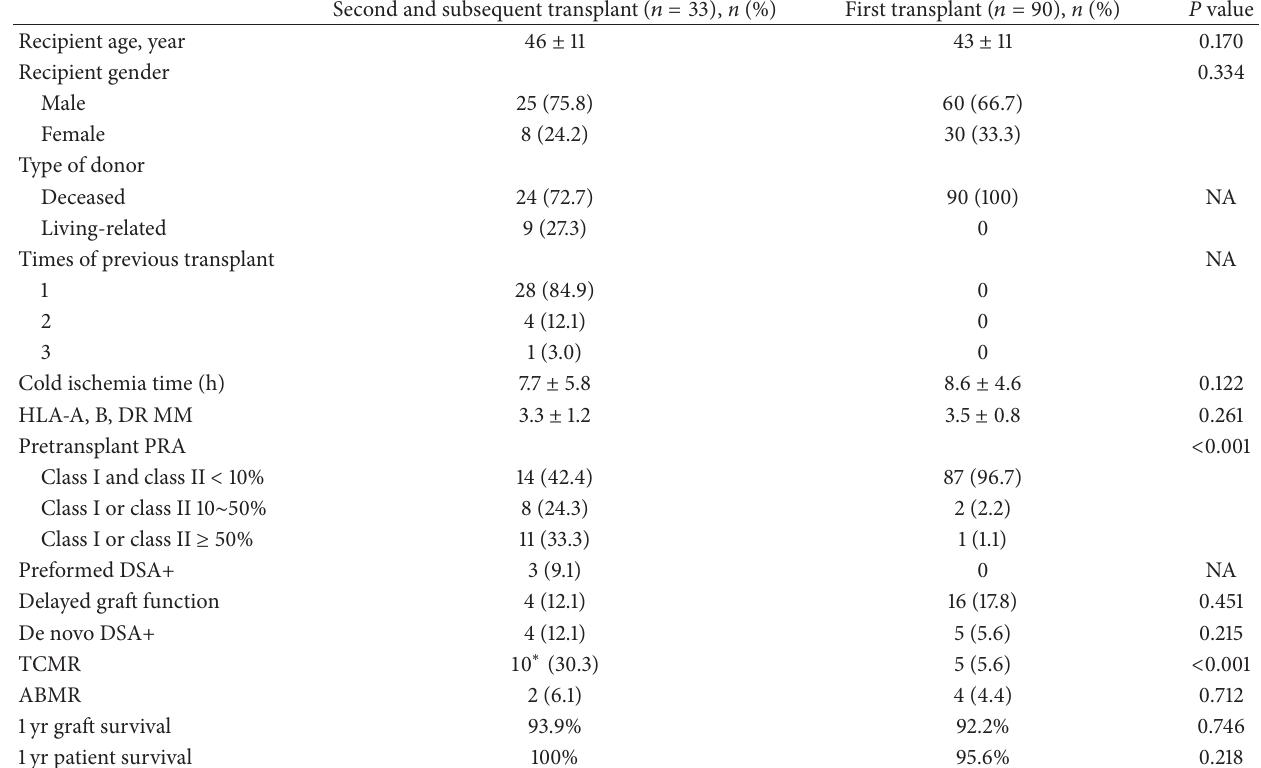
Table 1: Demographics and early transplant